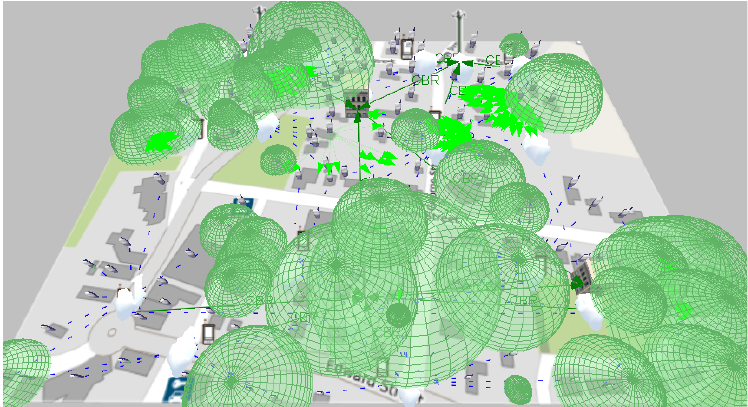
Figure 8. Scenario simulation with 100-m range WiFi technology.